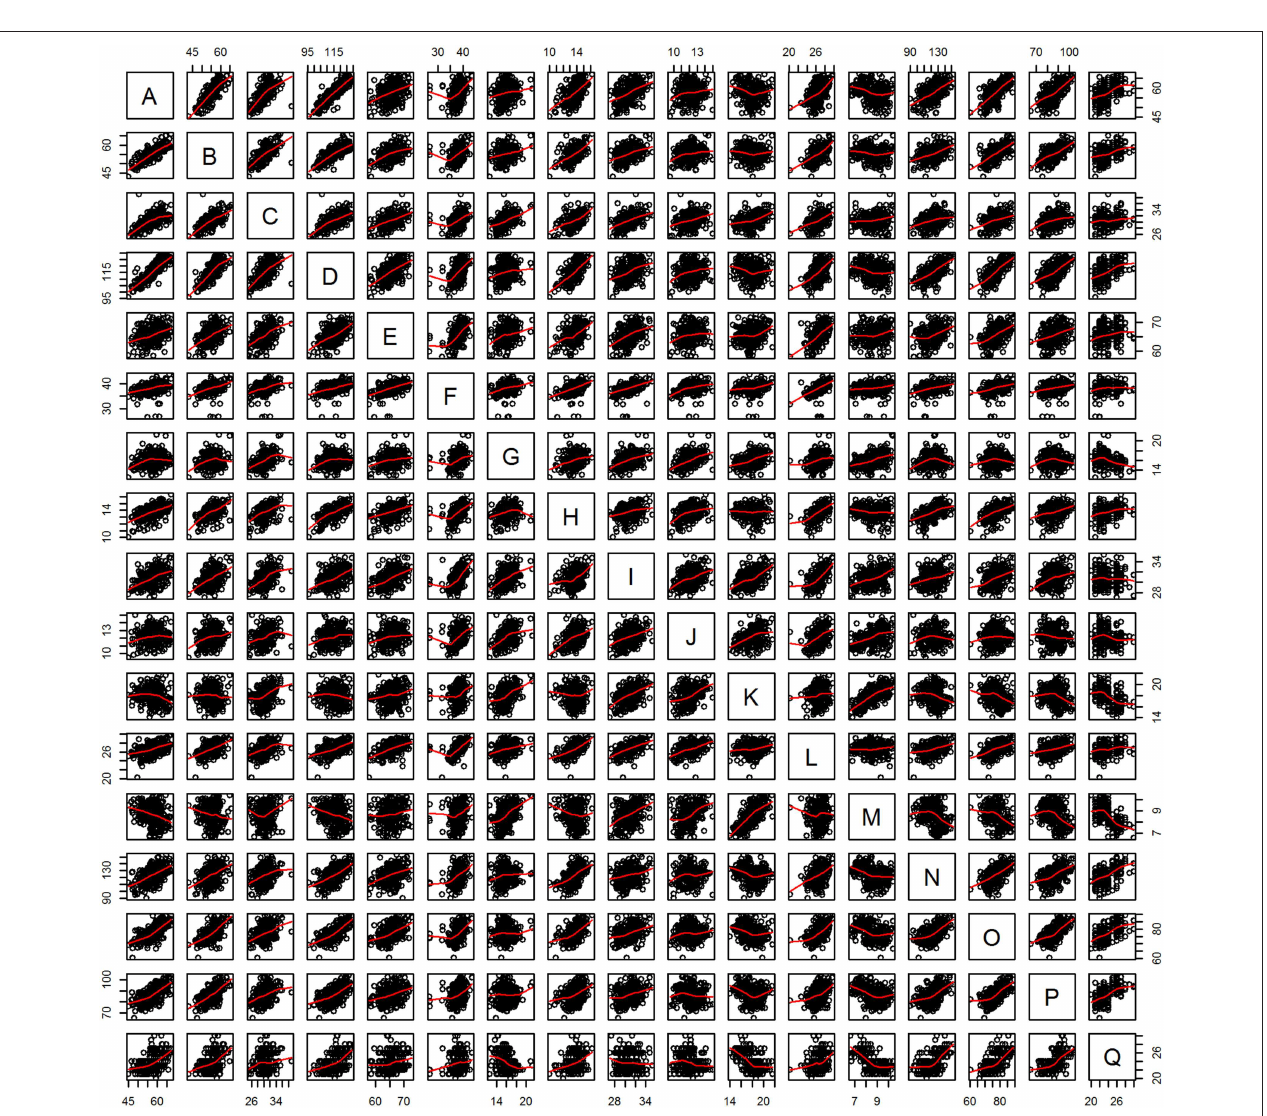
FIGURE 3 | Panel plot of observations against pairs of variables. Trend lines in red. See Table 2 for variable name acronyms.